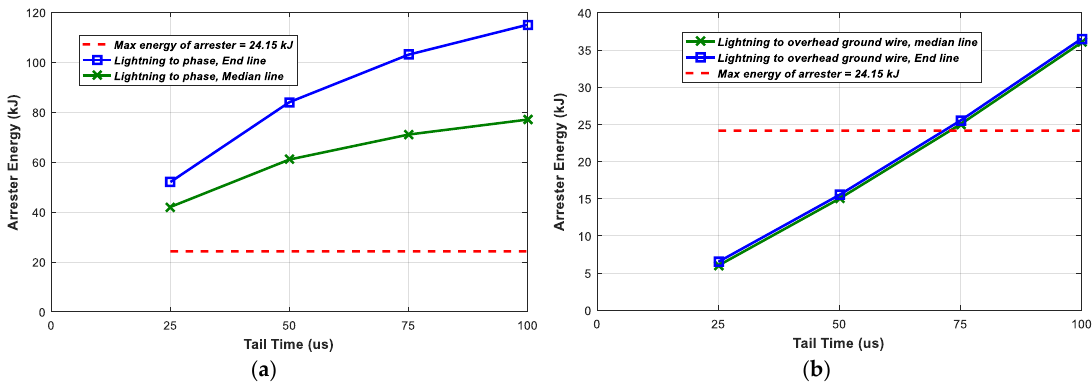
Figure 22. Arrester energy discharge against tail time lightning current wave shapes (front time = 4.12 μs, lightning current = 40 kA, 200 m grounding distance of the overhead ground wire, 10 Ω ground resistance); ( a ) Strike to the phase conductor; ( b ) Strike to the overhead ground wire.